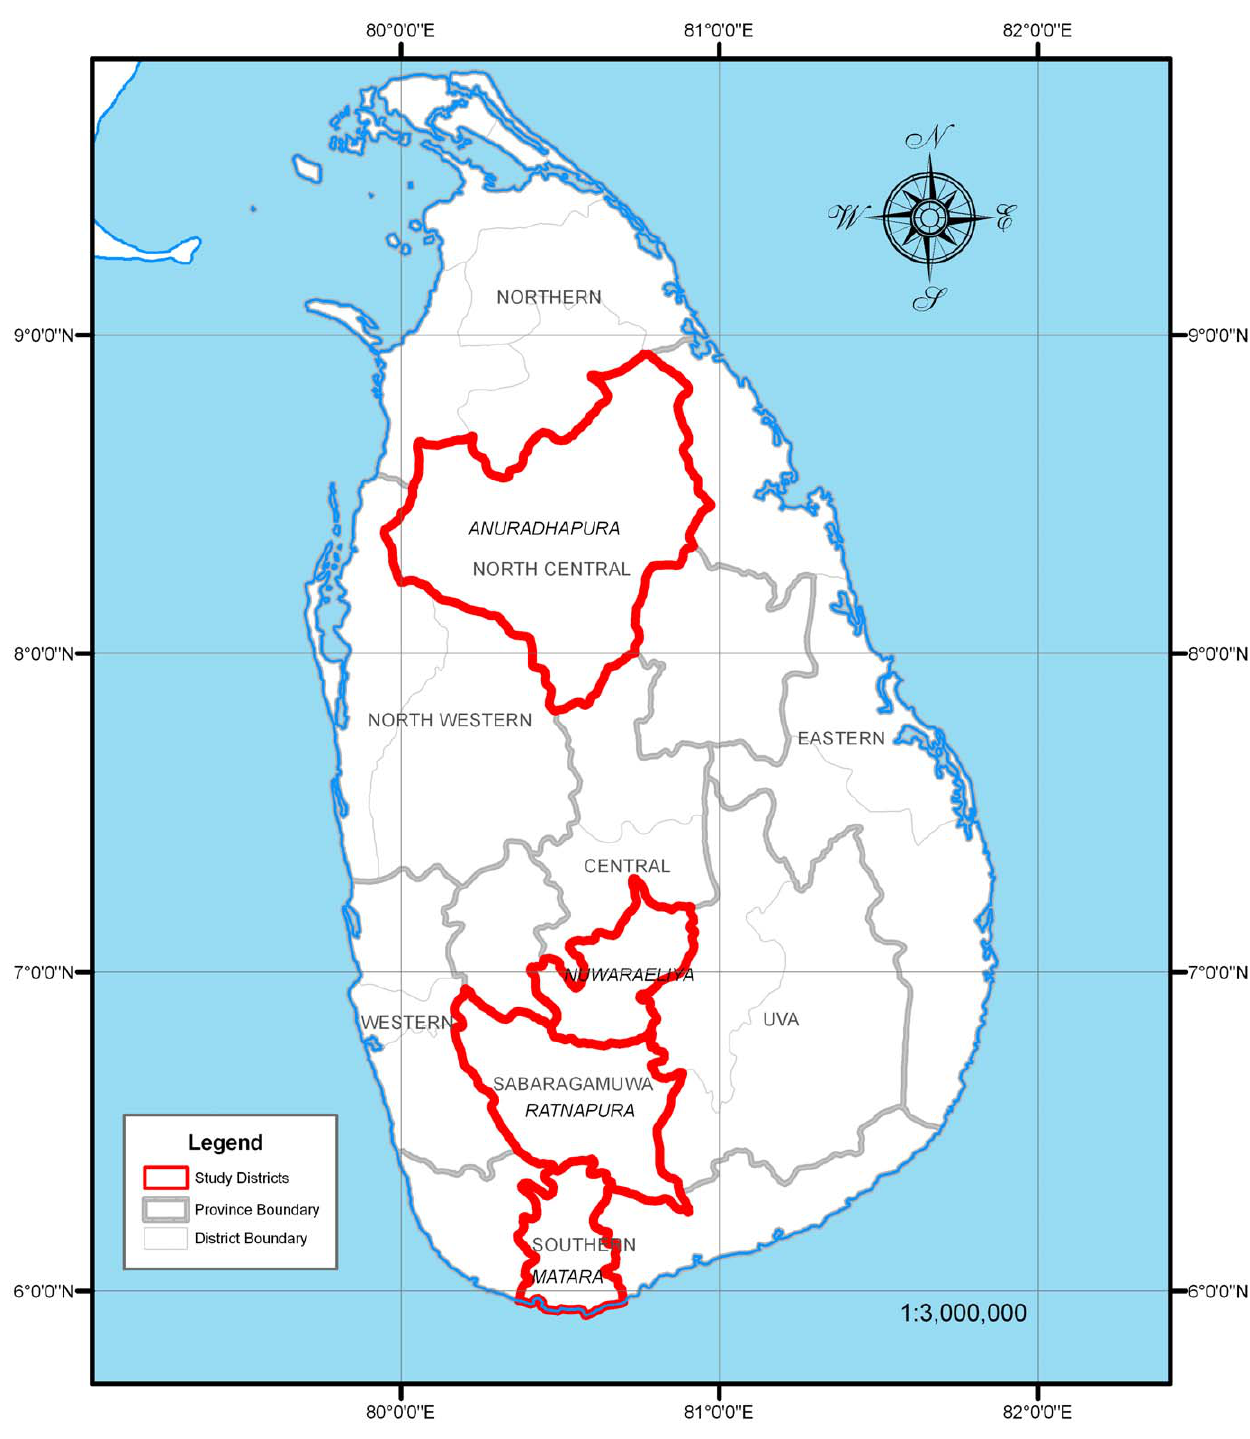
Figure 1. Study Area Map. Map of Sri Lanka and study districts that were part of the Infectious Disease Surveillance and Analysis System.